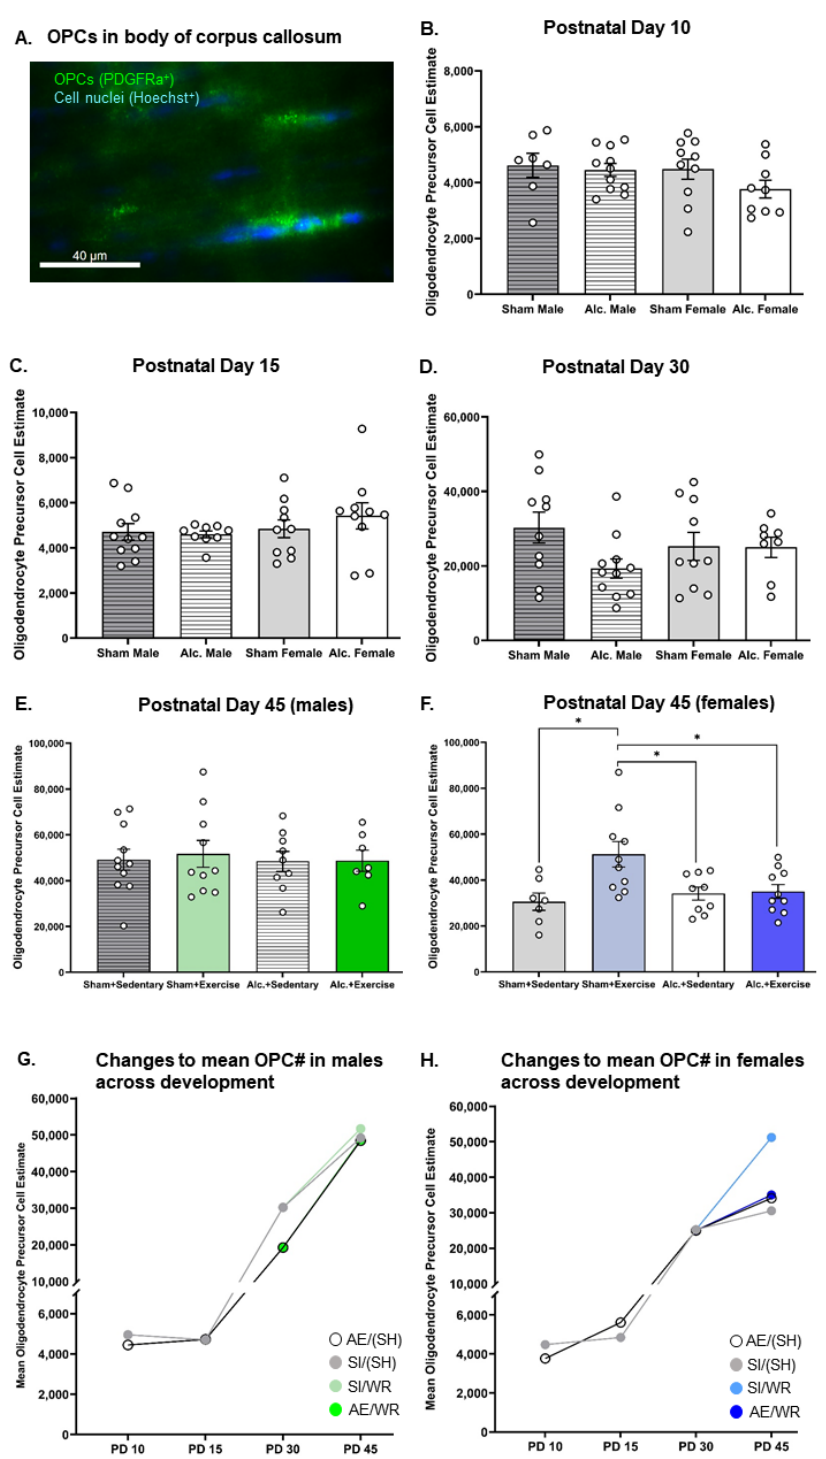
Figure 3. OPC quantification in the body of CC from PD 10 to 45. ( A ) Example of fluorescent staining used to visualize OPCs in corpus callosum, scale bar = 50 µ m; ( B – D ) Comparison of the number of OPCs in the body of CC in brain tissue extracted from AE and SI rats from both sexes; ( E , F ) Comparison of the number of OPCs in the body of CC in SI/SH, SI/WR, AE/SH, and AE/WR male ( E ) and female ( F ) rats. Each data point in graphs B-F represents the mean estimate per rat and error bars represent ± SEM, * p ≤ 0.05; ( G , H ) Trajectories of OPC proliferation across all time points in the male ( G ) and female ( H ) brain in all postnatal treatment and intervention